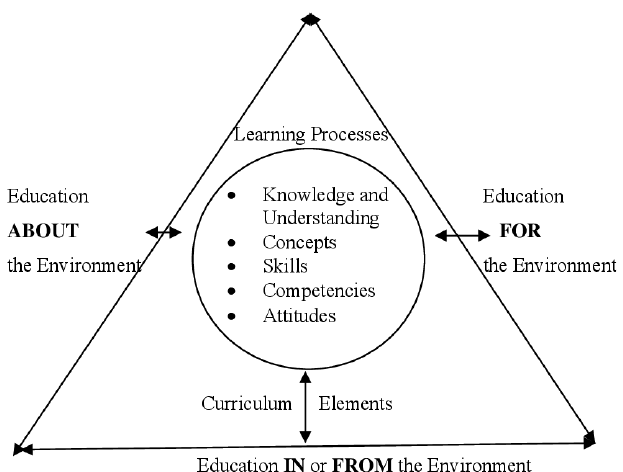
Fig. 1. Interrelated components in the planning of environmental education [8],